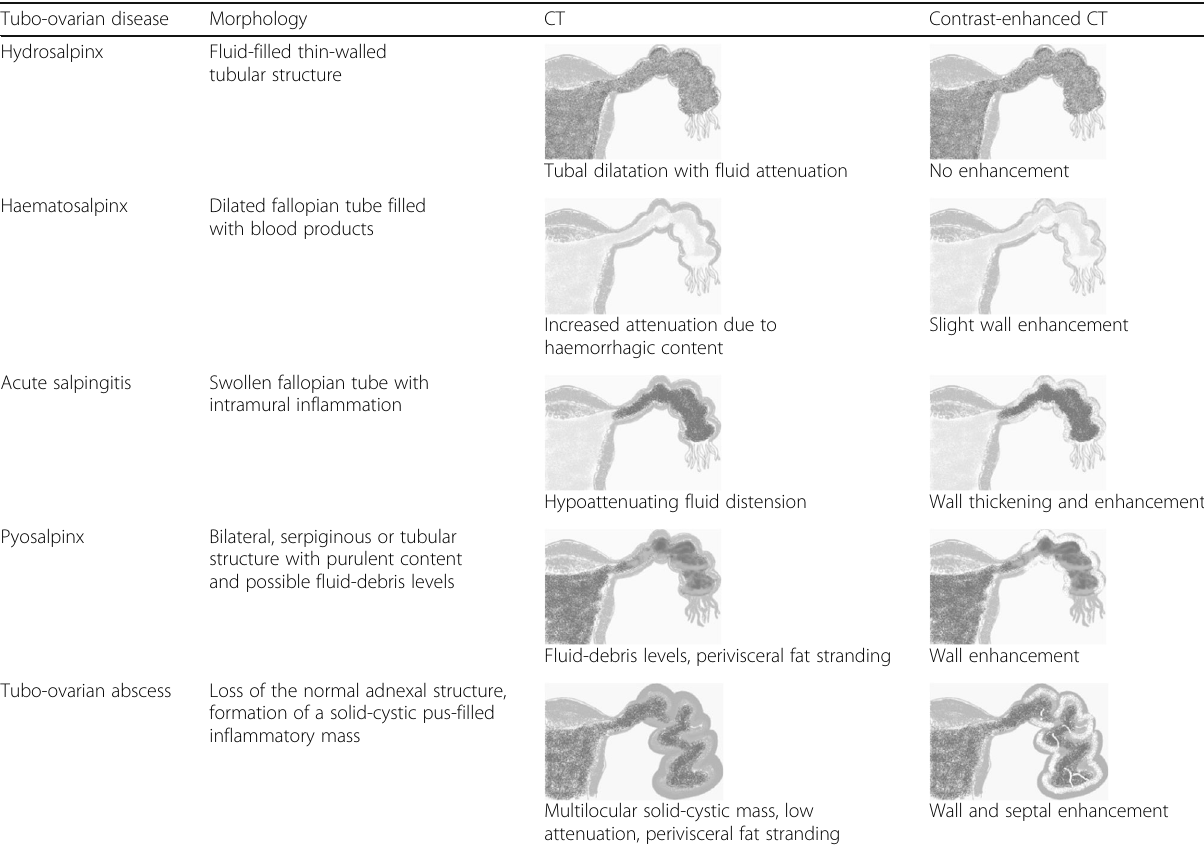
weighted sequences and heterogeneous signal intensity on Table 1 CT findings of pelvic inflammatory disease (PID) Tubo-ovarian